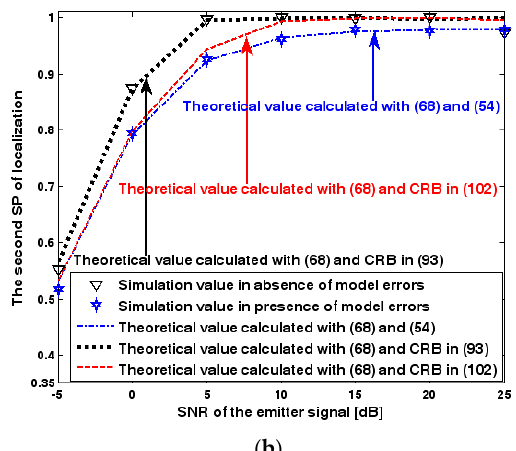
Figure 13. Success probability (SP) of localization versus SNR of the emitter signal. ( a ) The first SP of localization versus SNR of the emitter signal. ( b ) The second SP of localization versus SNR of the emitter signal.